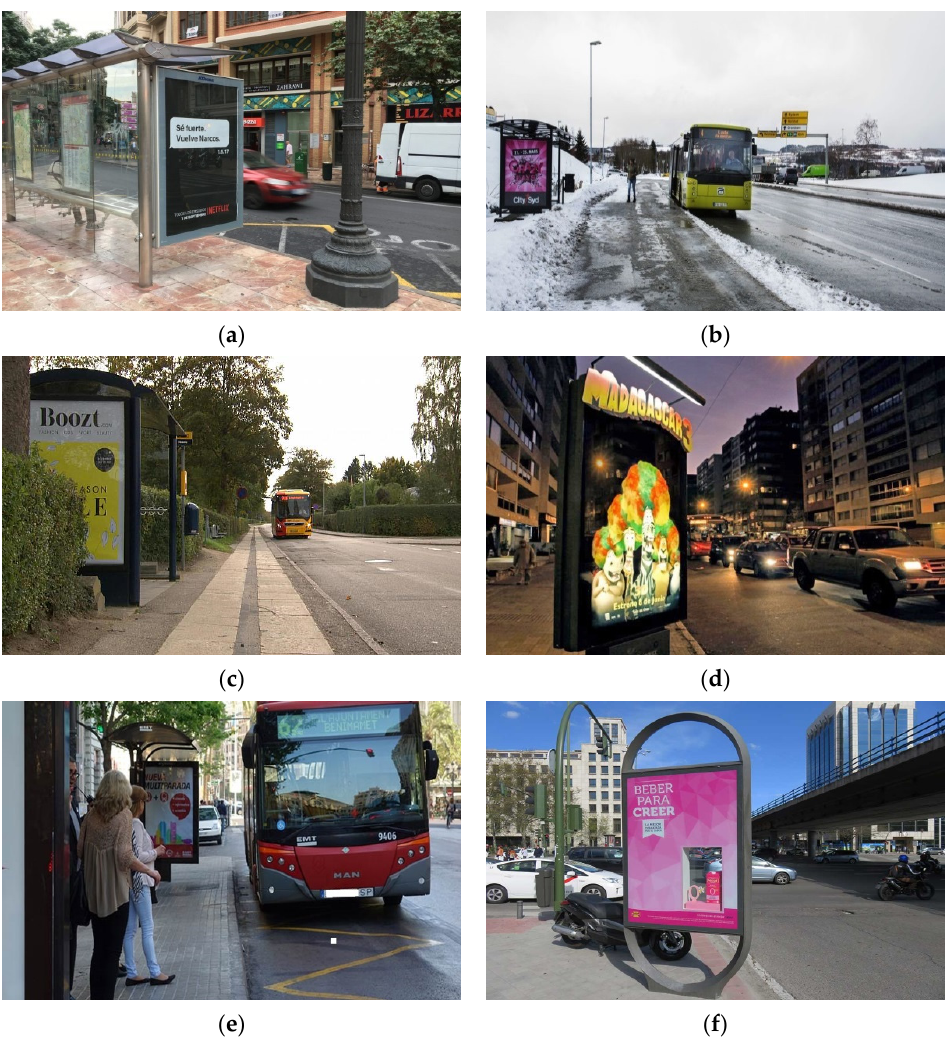
Figure 6. Test images of panels including some considered variabilities: ( a ) rotated panel; ( b ) reduced size ratio with respect to image size (smaller than 10%); ( c ) partial occlusion of panel; ( d ) night image; ( e ) combined reduced size and partial occlusion of panel; ( f ) combined rotated panel with “window”.